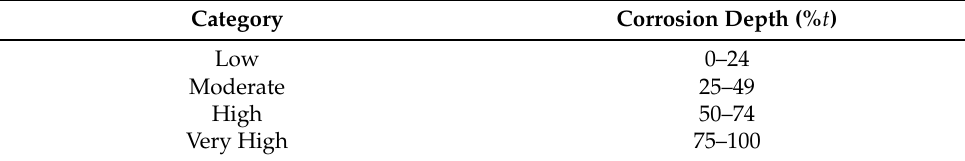
Table 2. Corrosion severity